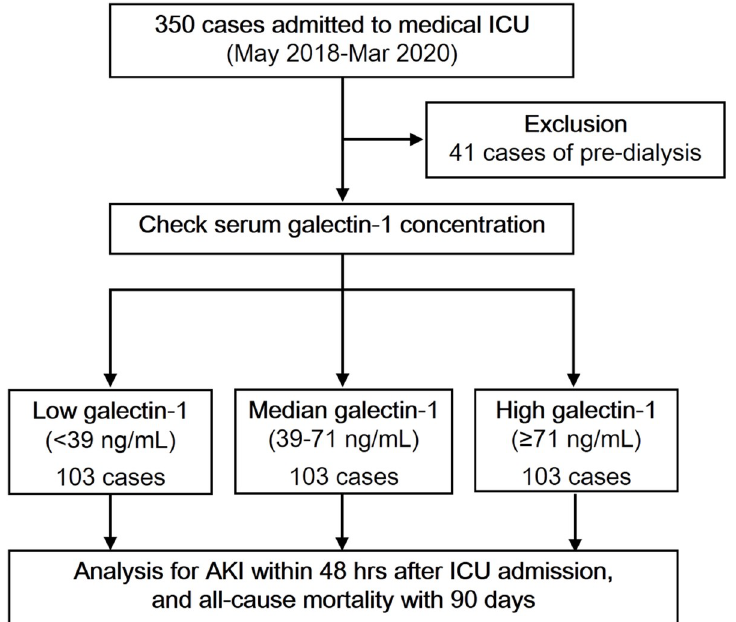
Fig 1. Flowchart of patient enrollment and classification. ICU, intensive care unit; AKI, acute kidney injury.